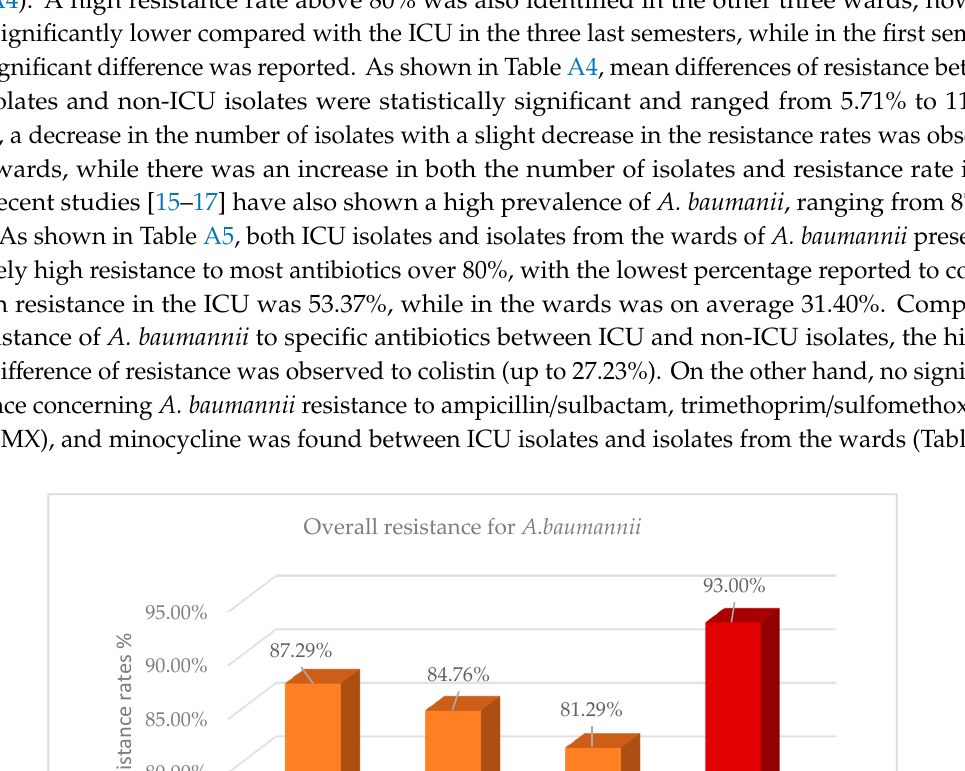
Figure 1. Resistance rates for Pseudomonas aeruginosa per ward during the 2-year period (2017–2018). For the same 2-year period, overall resistance of A. baumanii in the ICU was 93% (Figure 2, Table